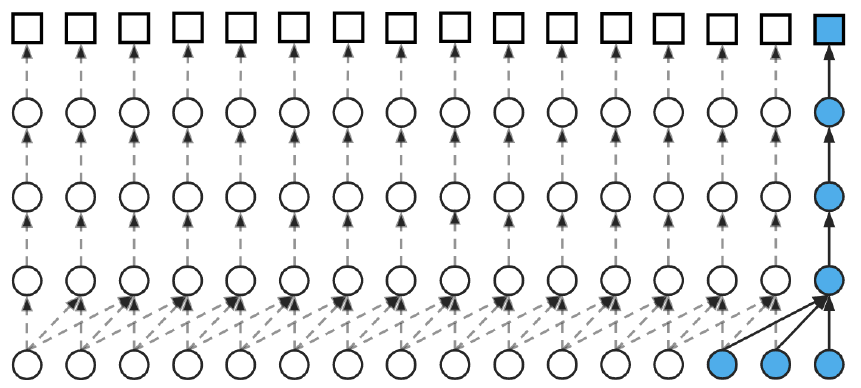
Figure 6. Learning process of early fusion (Note: Blue denotes the number of nodes needed in current